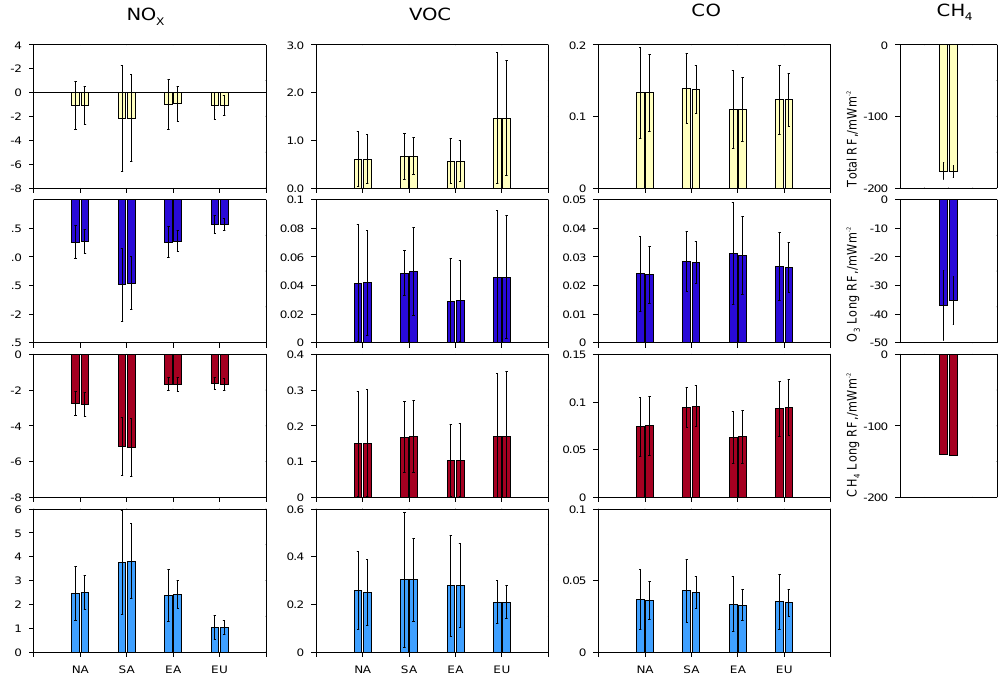
Figure 4. Ensemble-mean radiative forcing, normalised by emissions mass change, for (first column) NO x , (second column) VOCs, (third column) CO, and (right) CH 4 , for (top, yellow) total RF, (second row, dark blue) RF due to long-lived ozone, (third row, red) RF due to methane, and (bottom row, pale blue) RF due to short-lived ozone. For each pair of bars, the right-hand bar denotes the true mean, RF, and the left-hand bar gives the ensemble value calculated using the method of Fry et al. (2012), RF EN . Units are mWm − 2 ( Tgyear − 1 ) − 1 for the NO x , VOCs and CO cases. For the CH 4 case, results are presented un-normalised, in mWm − 2